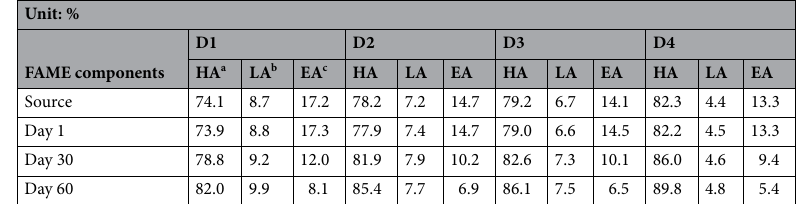
Table 3. Relative FAME compositions in the diesel sources and soil samples contaminated with the corresponding sources at different weathering times. a HA: Heptadecanoic acid methyl ester. b LA: Linolenic acid methyl ester. c EA: Elaidic acid methyl ester.